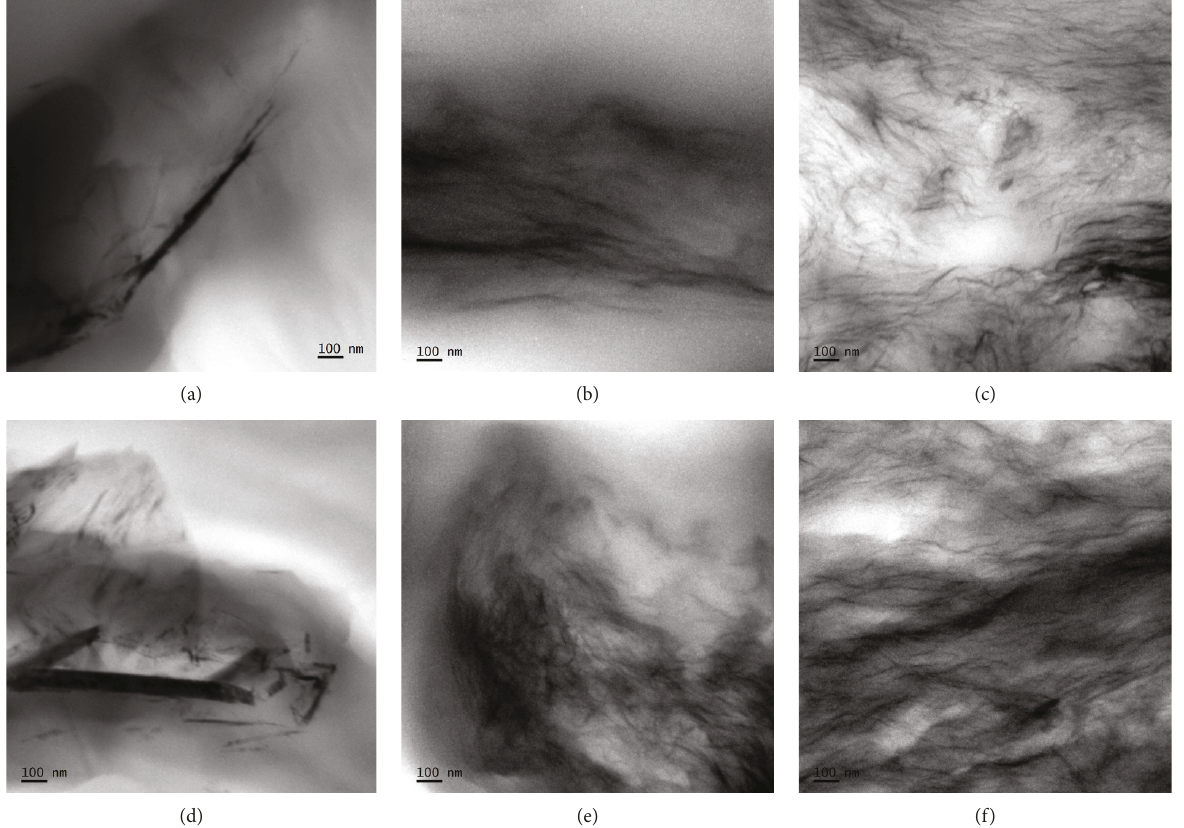
Figure 10: TEM microphotographs of (a) PU20/GNP1%, (b) PU20/RGO1%, (c) PU20/RGO2%, (d) PU40/GNP1%, (e) PU40/RGO1%, and (f)